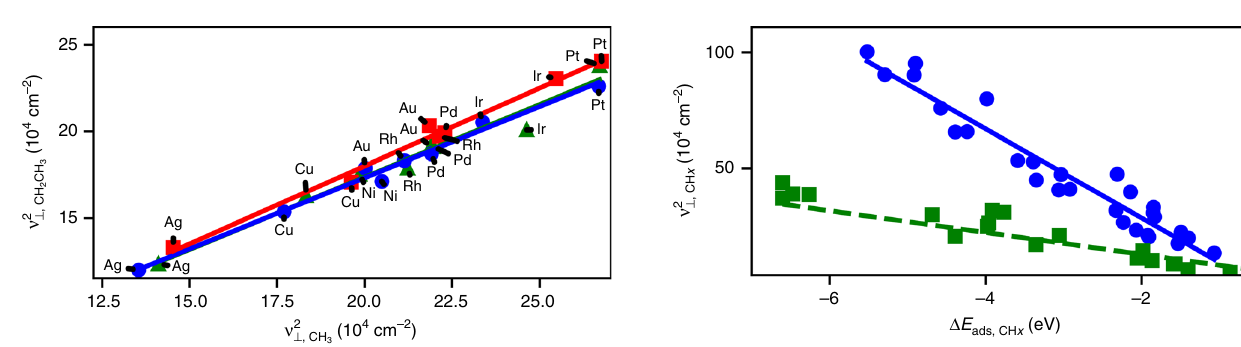
Fig. 6 Scaling of frequencies with adsorption energy. Frequencies are for Fig. 5 Scaling of ν ⊥ for CH 2 CH 3 vs. CH 3 . The data is calculated from DFT at the ν ⊥ mode and calculated from DFT for CH X species, where X ≥ 0. the atop site. The data include vibrations on (100) (green triangles), (111) Included are modes and adsorption energies at atop sites (blue circles) and (blue circles), and (110) (red squares) transition metal surfaces. The slopes fcc hollow sites (green squares). Fits to Eq. (17) are shown by solid blue and of the regressed lines are 0.90, 0.82, and 0.83 for the red, blue and green dashed green lines, respectively. The slopes of the regressed lines are lines, respectively − 192,000 and − 63,100 for the blue and green lines, respectively. The intercepts are also best fi t value of γ used in scaling adsorption energy on Pt- bimetallic alloys was 0.67 30 . Our value of 0.58 for the VSR slope ∂ 2 g is not zero or indicates that either ∂ γ ∂ ∂ r 2 is not constant, but the r minor deviation from 0.67 suggests such assumptions are a good